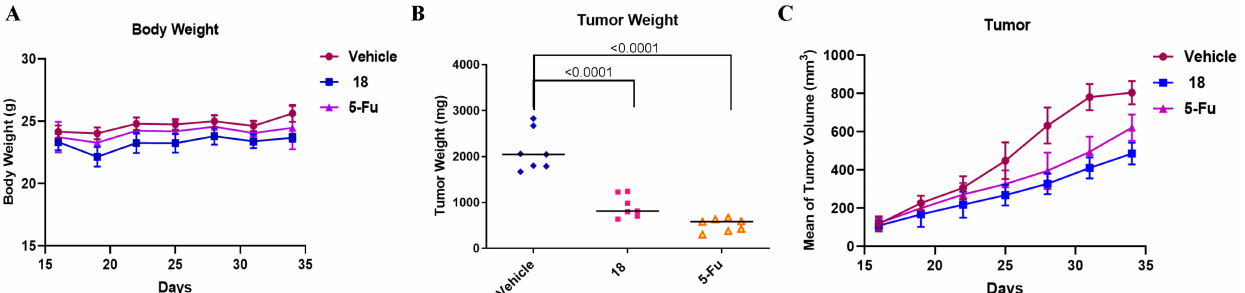
Figure 7. The in vivo anti-proliferative effect of 18 on the gastric cancer xenograft model. ( A ) The effect of compound 18 (25 mg/kg) on body weight, with 5-Fu (10 mg/kg) used as the control; ( B ) The effect of compound 18 (25 mg/kg) on the tumor weight, with 5-Fu (10 mg/kg) used as the control; ( C ) The effect of compound 18 (25 mg/kg) on the tumor volume, with 5-Fu (10 mg/kg) used as the